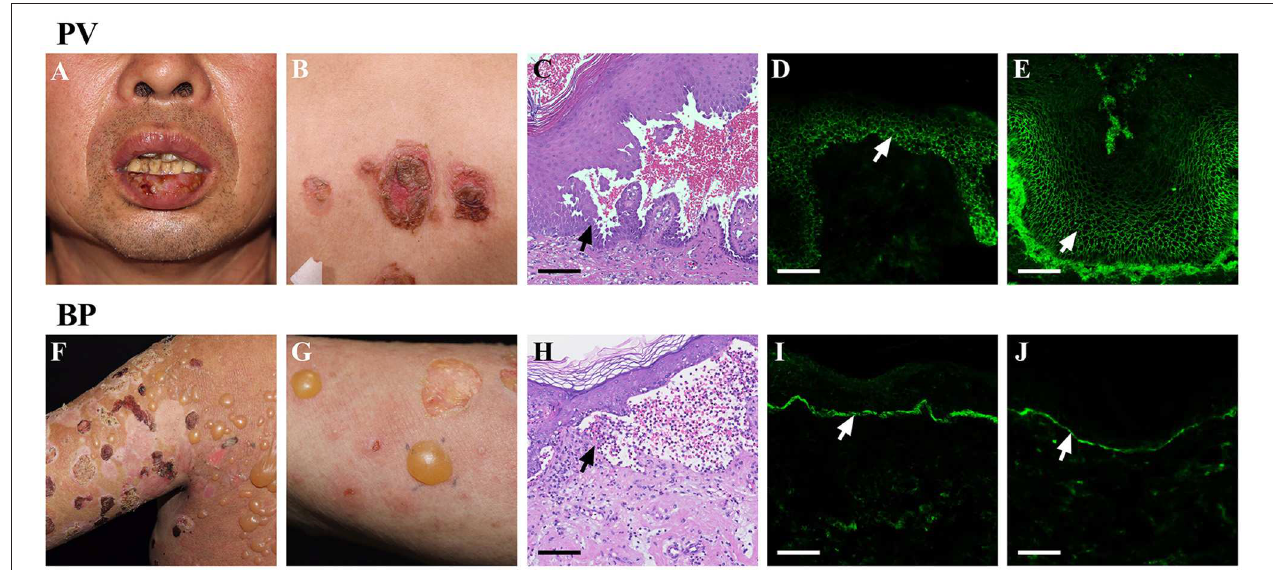
FIGURE 1 | Clinical and immunohistological features of AIBD. AIBD contains two groups: pemphigus group and pemphigoid group. The representative members of these two groups are PV and BP. PV can present with erosions on the mucous membranes (A) , and flaccid vesicles or erosion on the skin (B) . Haematoxylin and eosin (HandE) staining of PV lesions demonstrates an intraepithelial blister with acantholysis (C) . DIF of PV lesions shows IgG antibodies deposit on the surface of keratinocytes (D) . IIF using monkey esophagus shows serum IgG autoantibodies from patients with PV bind to the surface of epitheliums (E) . Whereas, BP presents with large, tense bullae, and erythematous patches on the skin (F,G) . H & E staining of BP lesions reveals an subepidermal blister with eosinophil-rich inflammatory infiltration in the superficial dermis (H) . DIF of BP lesions shows IgG antibodies deposit along the dermoepidermal junction (I) . IIF using normal skin shows the presence of serum IgG antibodies form BP patients bound to the dermoepidermal junction (J) . Bar = 100 µ